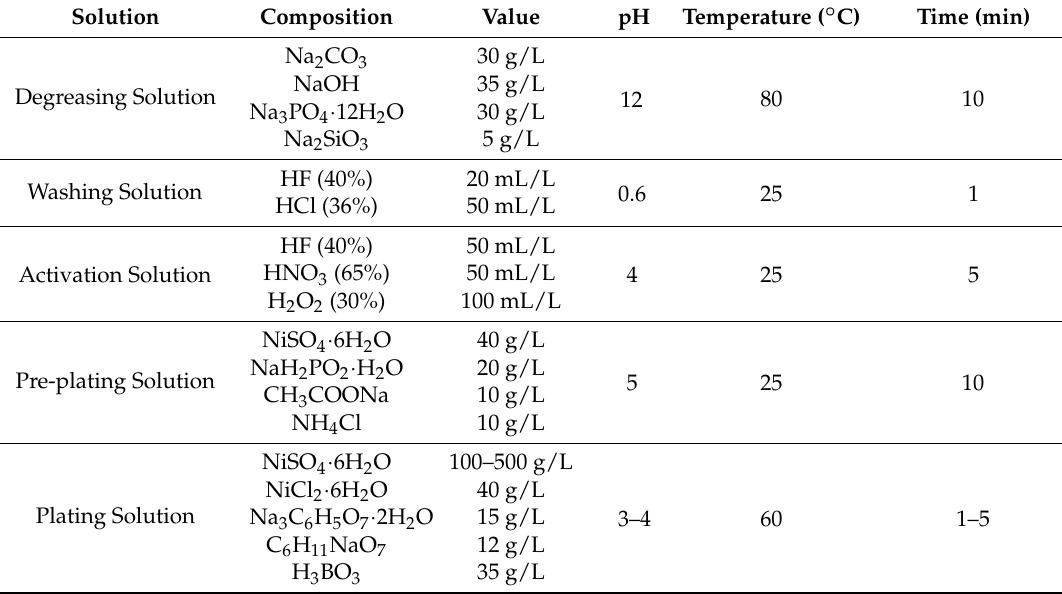
Table 1. Composition and processing parameters of degreasing, washing, activation, and plating solutions.